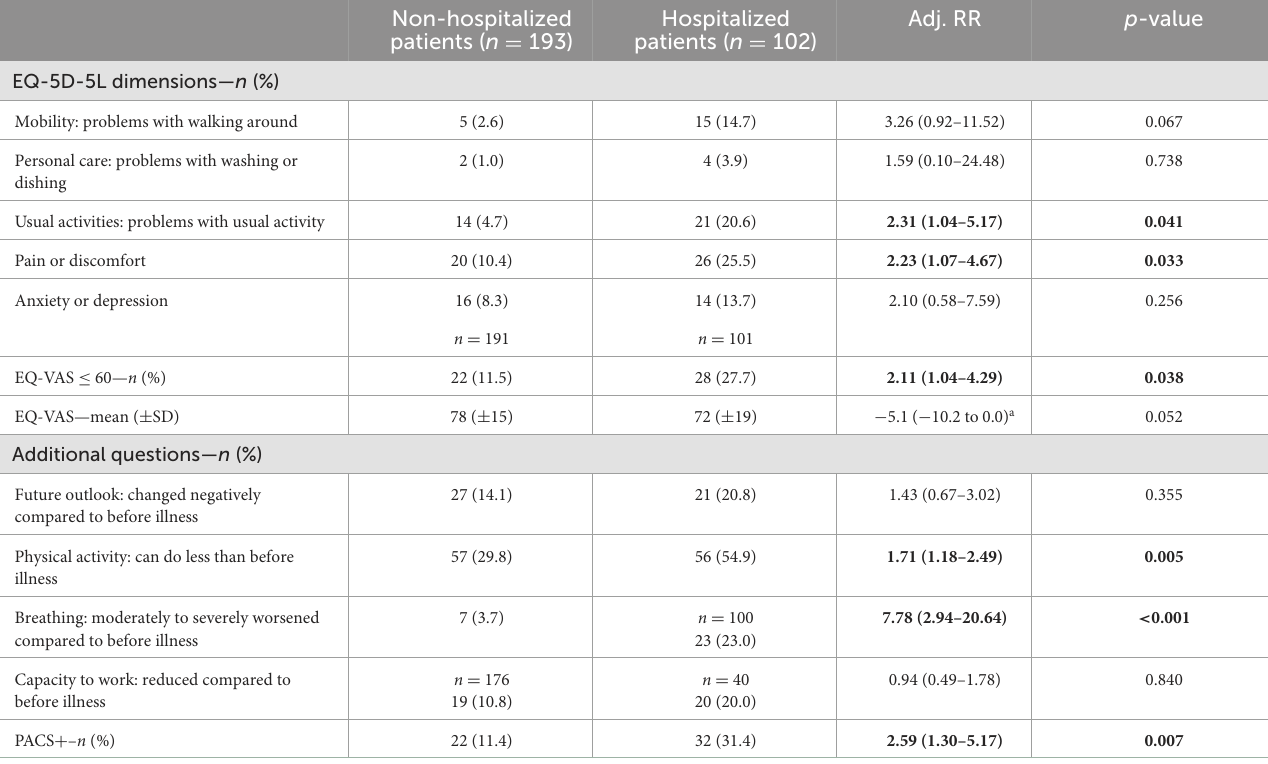
TABLE 3 Results from the multivariable regression analysis on the variables from the EQ-5D-5L questionnaire and the three additional questions added by the research group.